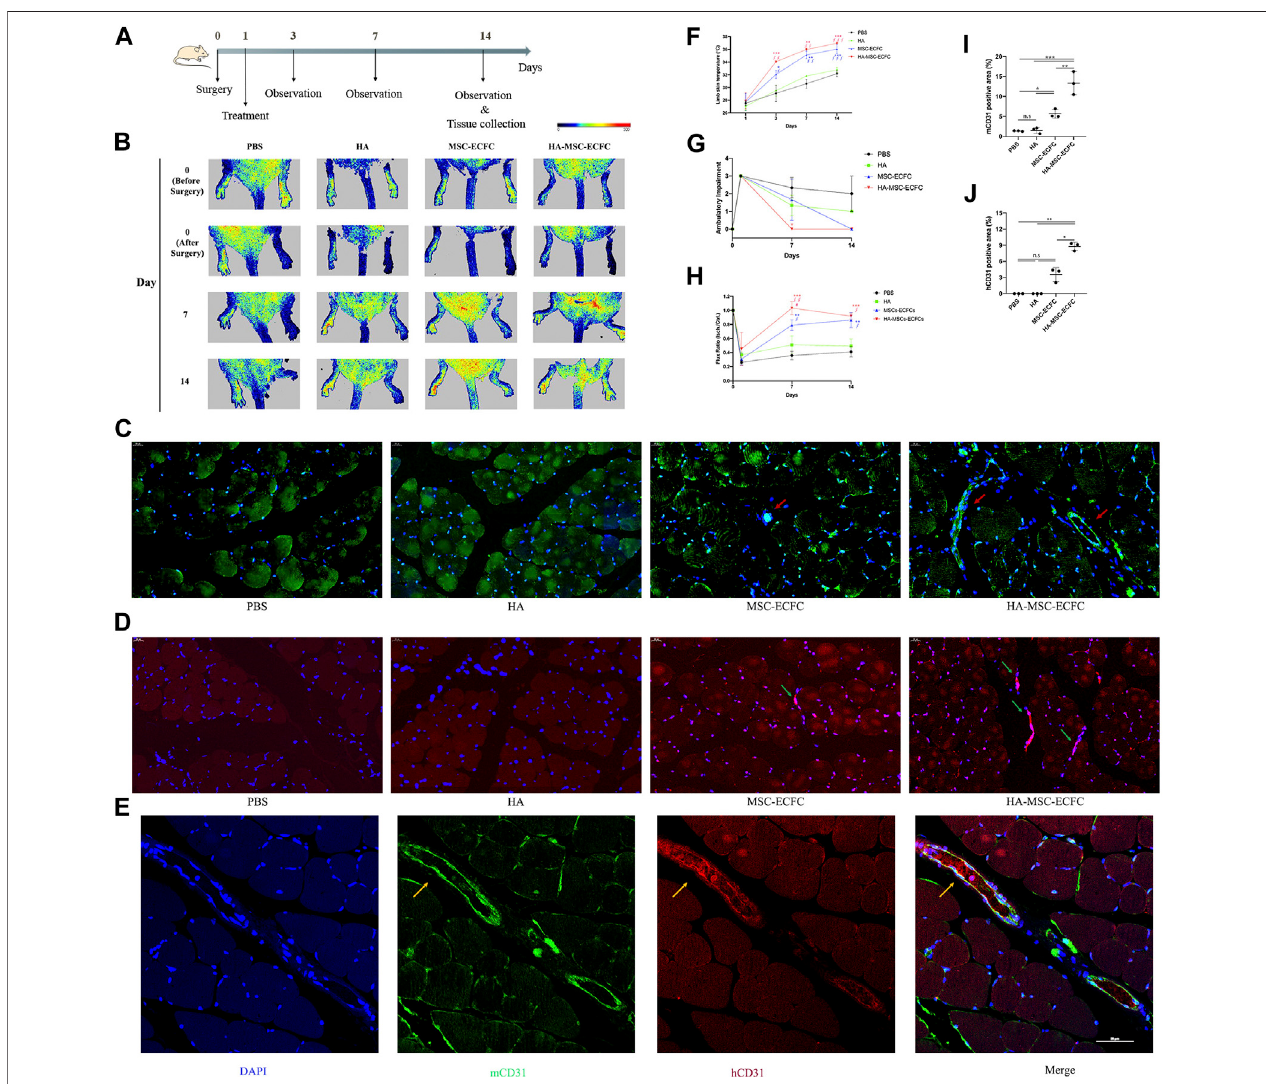
FIGURE 3 | HA improves MSC-ECFC-induced blood fl ow recovery of HLI in mice. (A) . The process of generating mouse models of hindlimb ischemia. (B) . Improvements in blood fl ow recovery were evaluated using PSI analysis in the ischemic limbs of 8-week-old mice injected with PBS, HA, MSCs-ECFCs or HA-MSCs- ECFCs before surgery and 0-, 7- and 14-days post-surgery. (C,D) . Representative fl uorescent images of mouse-speci fi c CD31 + tissue (C) and human-speci fi c CD31 + tissue (D) at 14 days after surgery (magni fi cation ×400, arrows indicate vessels) and quantitation of the CD31-positive percentage (I,J) , respectively ( n = 3 independent experiments. Error bars: mean ± SD. * p < 0.5, ** p < 0.1, *** p < 0.001). (E) . Representative confocal images of mouse-speci fi c CD31 + /human-speci fi c CD31 + double-stained muscles derived from ischemic tissue injected with HA-MSCs-ECFCs (magni fi cation ×400, yellow arrow indicates human-derived endothelial cells). (F) . Time course of the skin temperature in the ischemic limbs of the mice. (G) . Ambulatory impairment was scored at each time point: plantar/toe fl exion to resist gentle tail traction; 1: plantar but not toe fl exion; 2: no plantar or toe fl exion; and 3: no use of foot. (H) . Blood perfusion is presented as the ratio of blood fl ow in